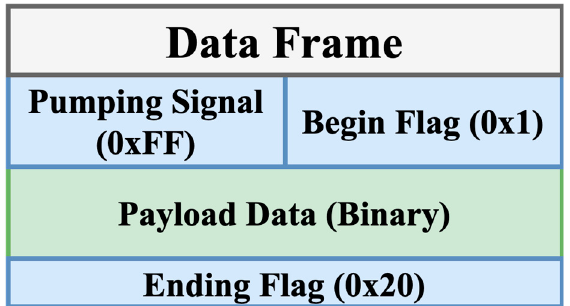
Figure 4. Format of presentation layer data frame.